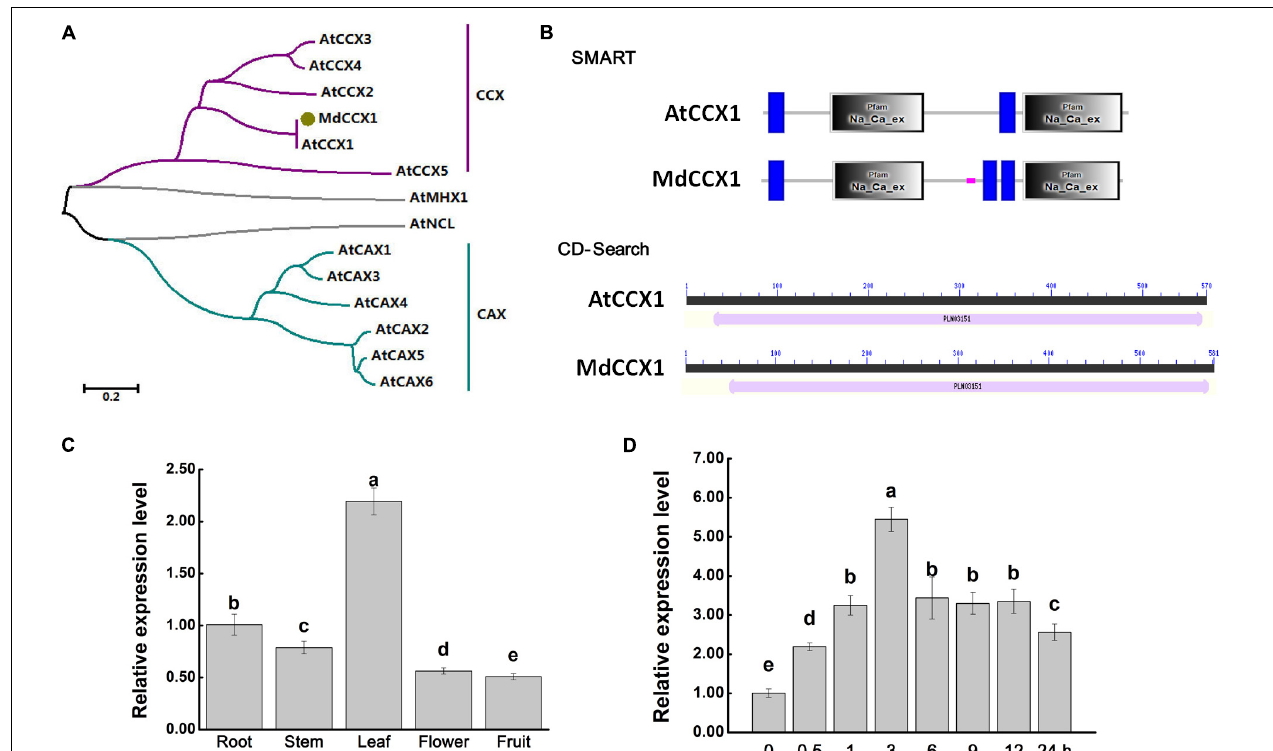
FIGURE 1 | Protein sequence analysis and gene expression identification of MdCCX1 . (A) Phylogenetic analysis of MdCCX1 and CaCA superfamily members in Arabidopsis . The phylogenetic was constructed with MEGA-X software. The scale bar represents 0.2 substitutions per site. (B) Conserved domains identified in AtCCX1 and MdCCX1 proteins using the online SMART database (http://smart.embl-heidelberg.de) and CD-Search tool (https://www.ncbi.nlm.nih.gov/Structure/cdd/wrpsb.cgi). (C) Relative expression levels of MdCCX1 in different apple tissues. (D) Relative expression levels